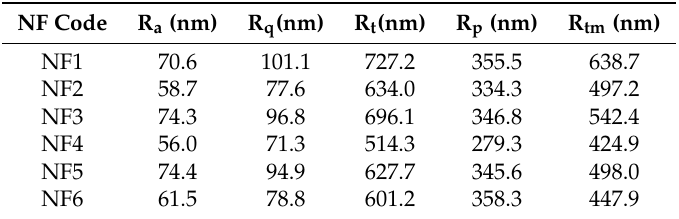
Table 2. Surface roughness parameters of nanofibrous formulations, including roughness average [R a ], root mean square roughness [R q ], the maximum height of the roughness [R t ], maximum roughness valley depth [R v ], maximum roughness peak height [R p ], and an average maximum height of the roughness [R tm ].